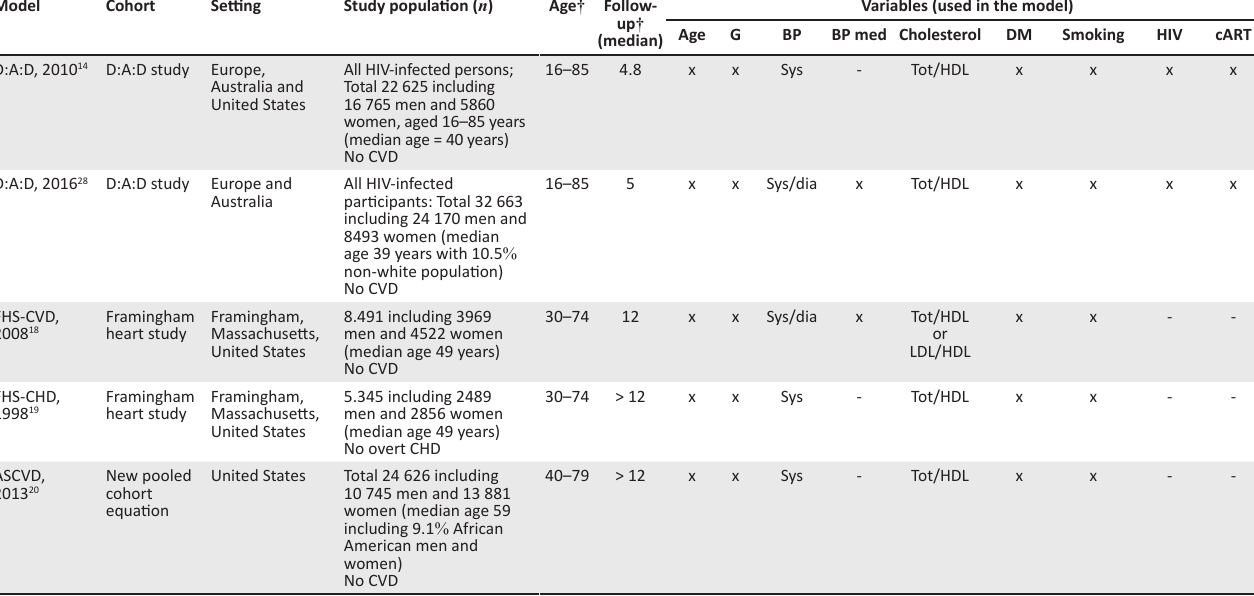
TABLE 1: Overview of the cardiovascular disease risk prediction models used in this study, showing the population characteristics and variables used by the different models.